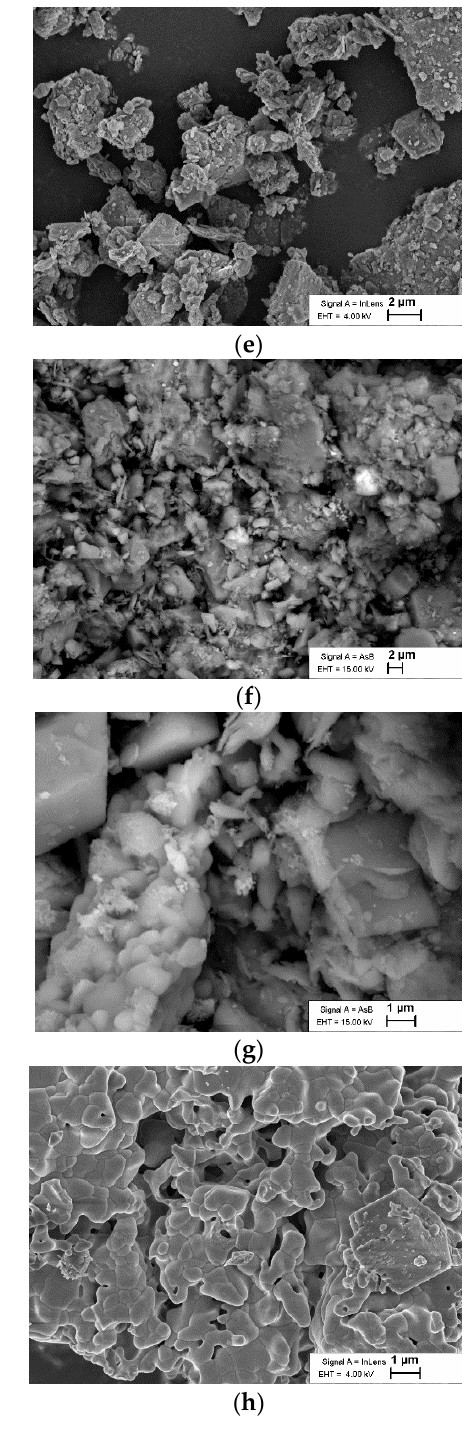
Figure 7. SEM photos of Pakri GA I: ( a ) initial, ( b ) 550 ◦ C, ( c ) 850 ◦ C, ( d ) 1000 ◦ C, and Sillamäe GA samples: ( e ) initial, ( f ) 550 ◦ C, ( g ) 850 ◦ C, ( h ) 1000 ◦ C (magnification: ( a , b , e , f ) = 5000 × ; ( c , d ) = 50,000 × ; ( g , h ) = 20,000 ×